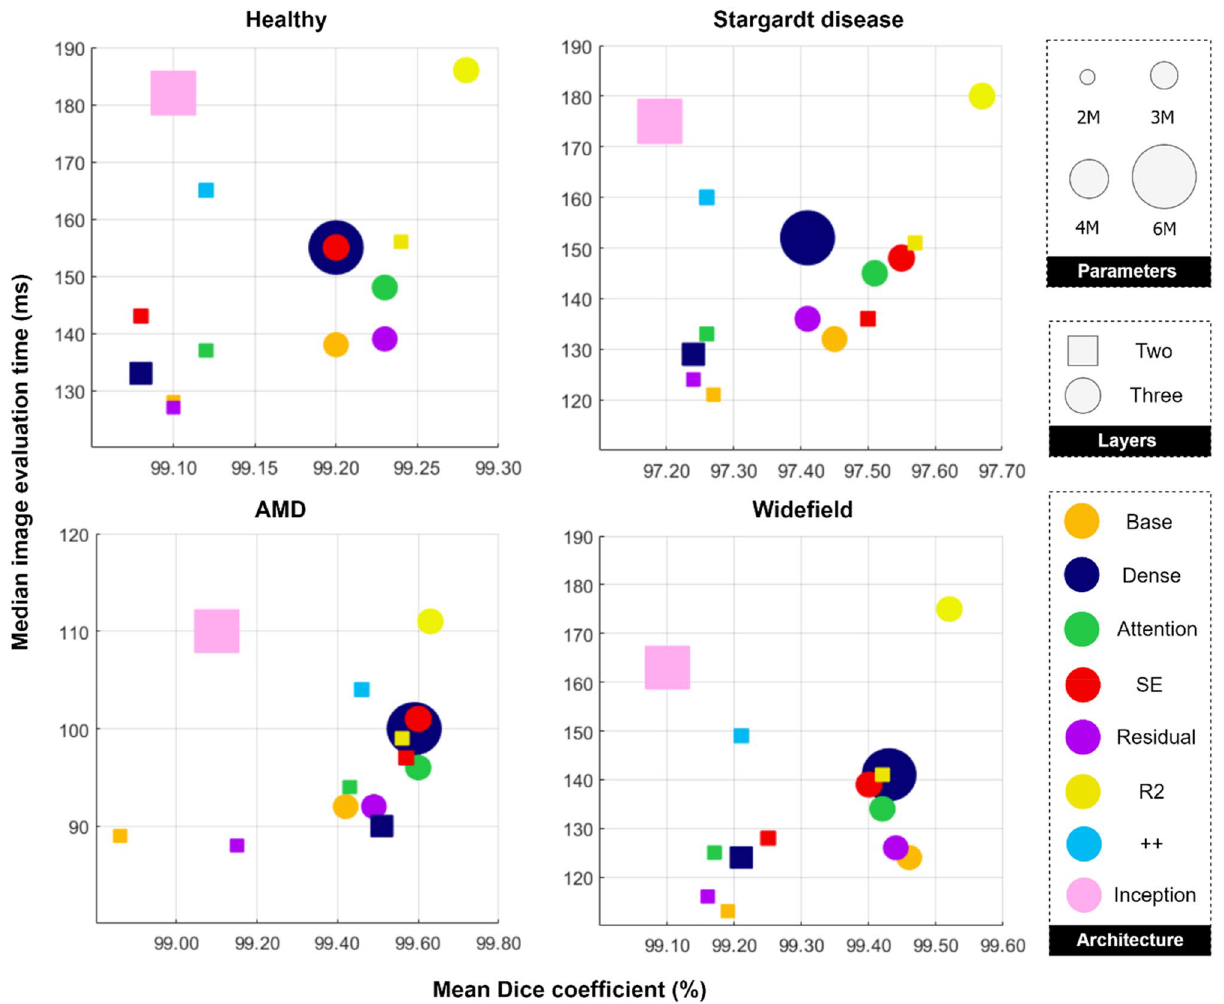
Figure 3. Segmentation accuracy (horizontal axis) vs. evaluation speed (vertical axis) vs. network parameters (size of symbol) for each of the datasets for two and three layers (square and circle symbols respectively) for each architecture tested. Note: the axis scales on each subplot differ to support optimal